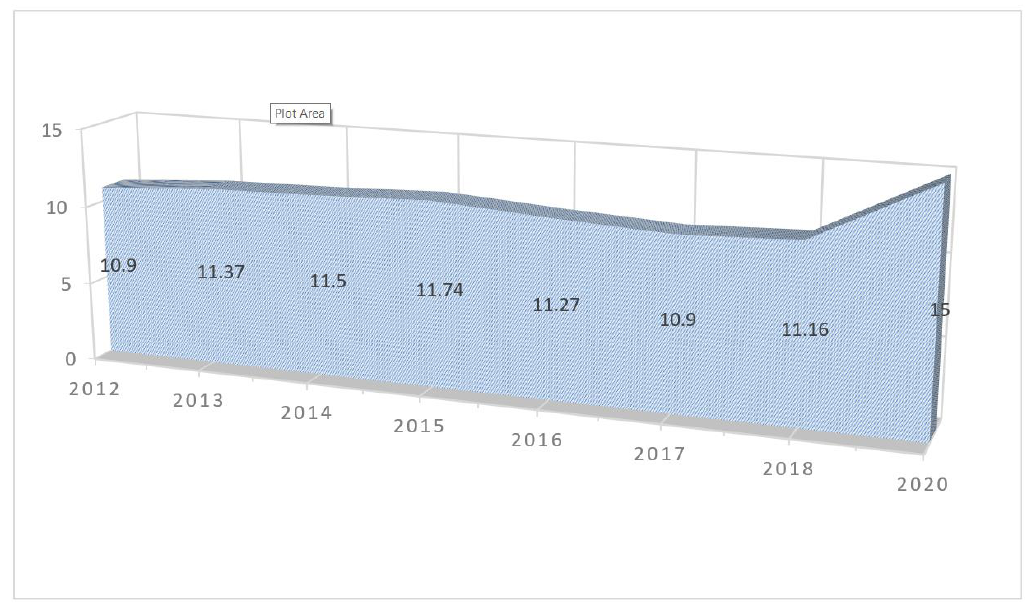
Figure 3. Share of energy from renewable sources in gross final energy consumption. Source: Authors’ study based on Eurostat databases.